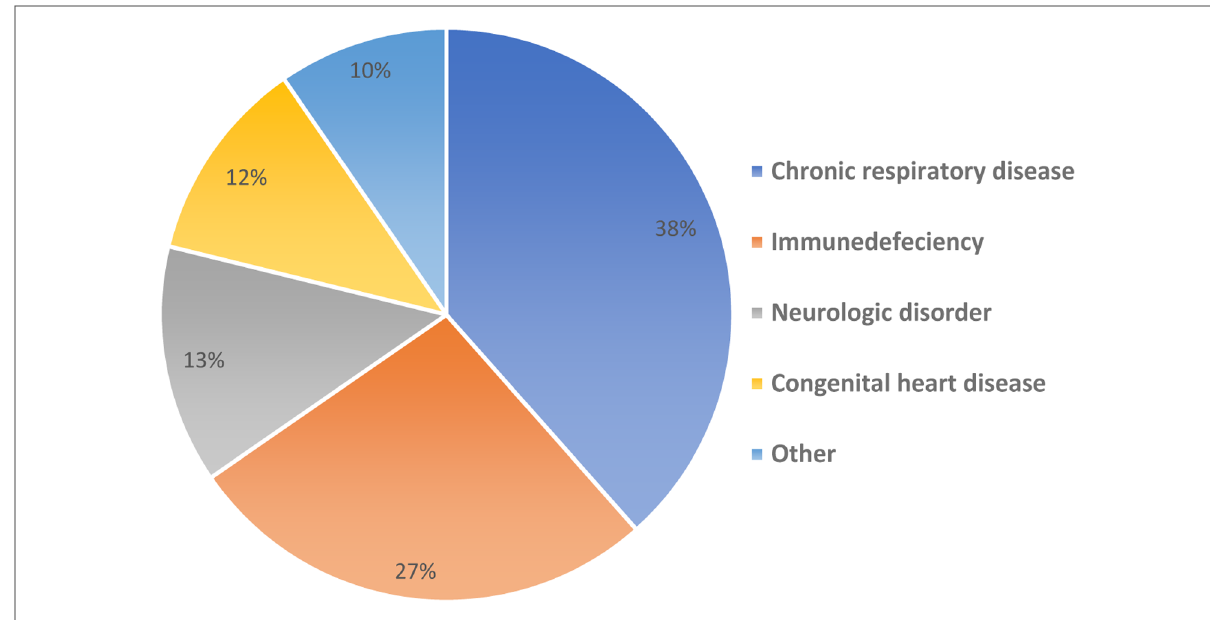
FIGURE 3 Background medical